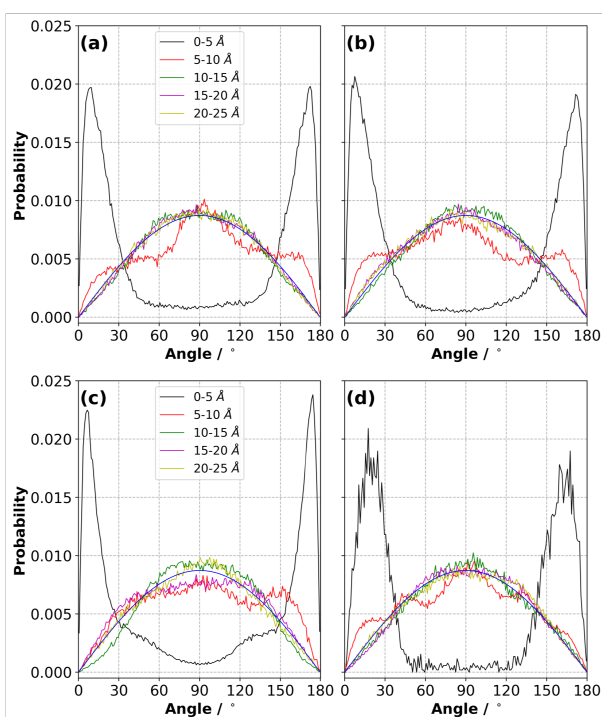
Figure 13. Angle distribution in the layers (up to 20 Å from each electrode) for the [C 2 mim] + ions in the [C 2 mim][NTf 2 ] IL for ( a ) Ψ − = 0 V, ( b ) Ψ + = 0 V, ( c ) Ψ − = 2 V and ( d ) Ψ + = 2 V at 294 K (averaged over three independently generated samples). The blue curve shows the distribution expected in a completely isotropic system.